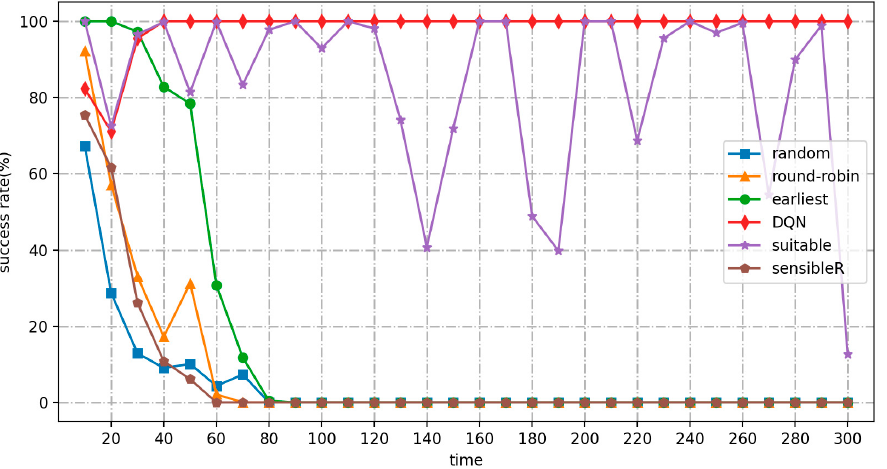
Figure 13. QoS satisfaction in high-frequency workload mode.